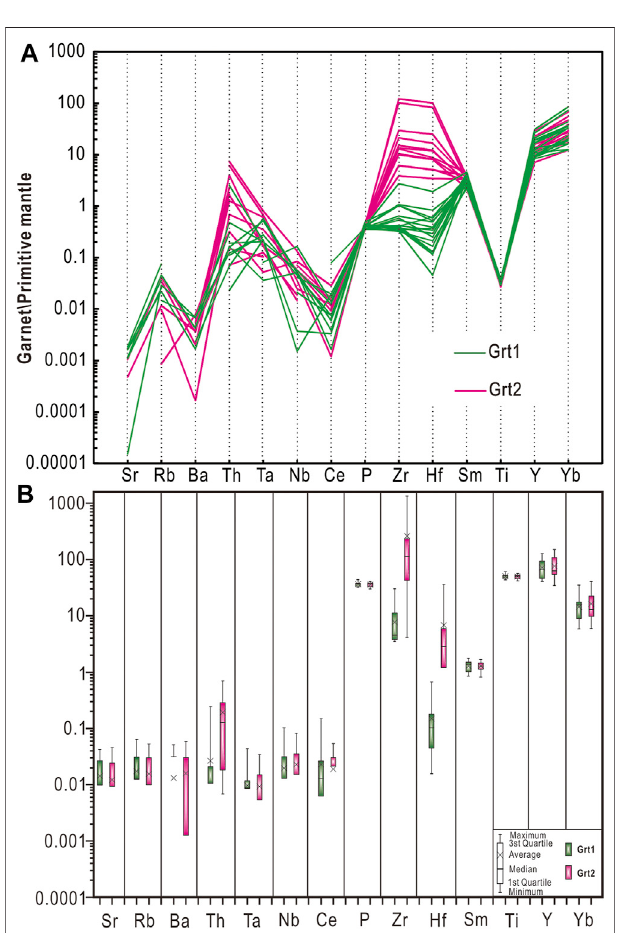
FIGURE 8 | (A) Primitive mantle-normalized multielement diagram and (B) the statistical column diagram of trace elements of the Tiemurt garnets.